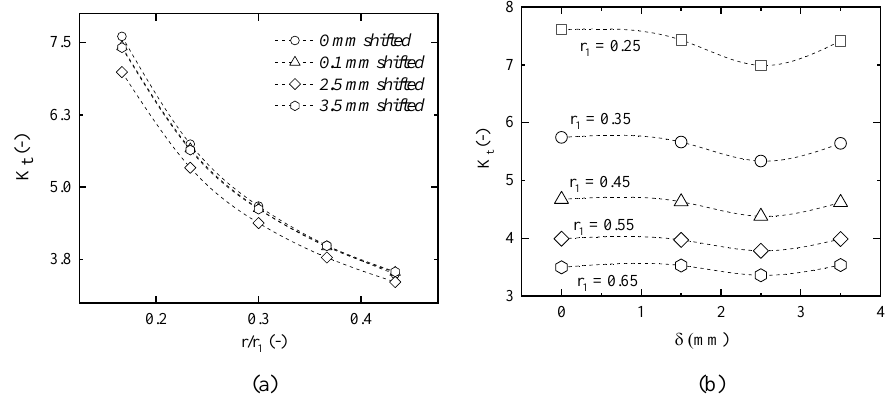
Figure 17. ( a ) Effect of elliptical channel radius on the stress concentration factor ( b )Effect of offset channel configuration on the stress concentration factor ( Kt).